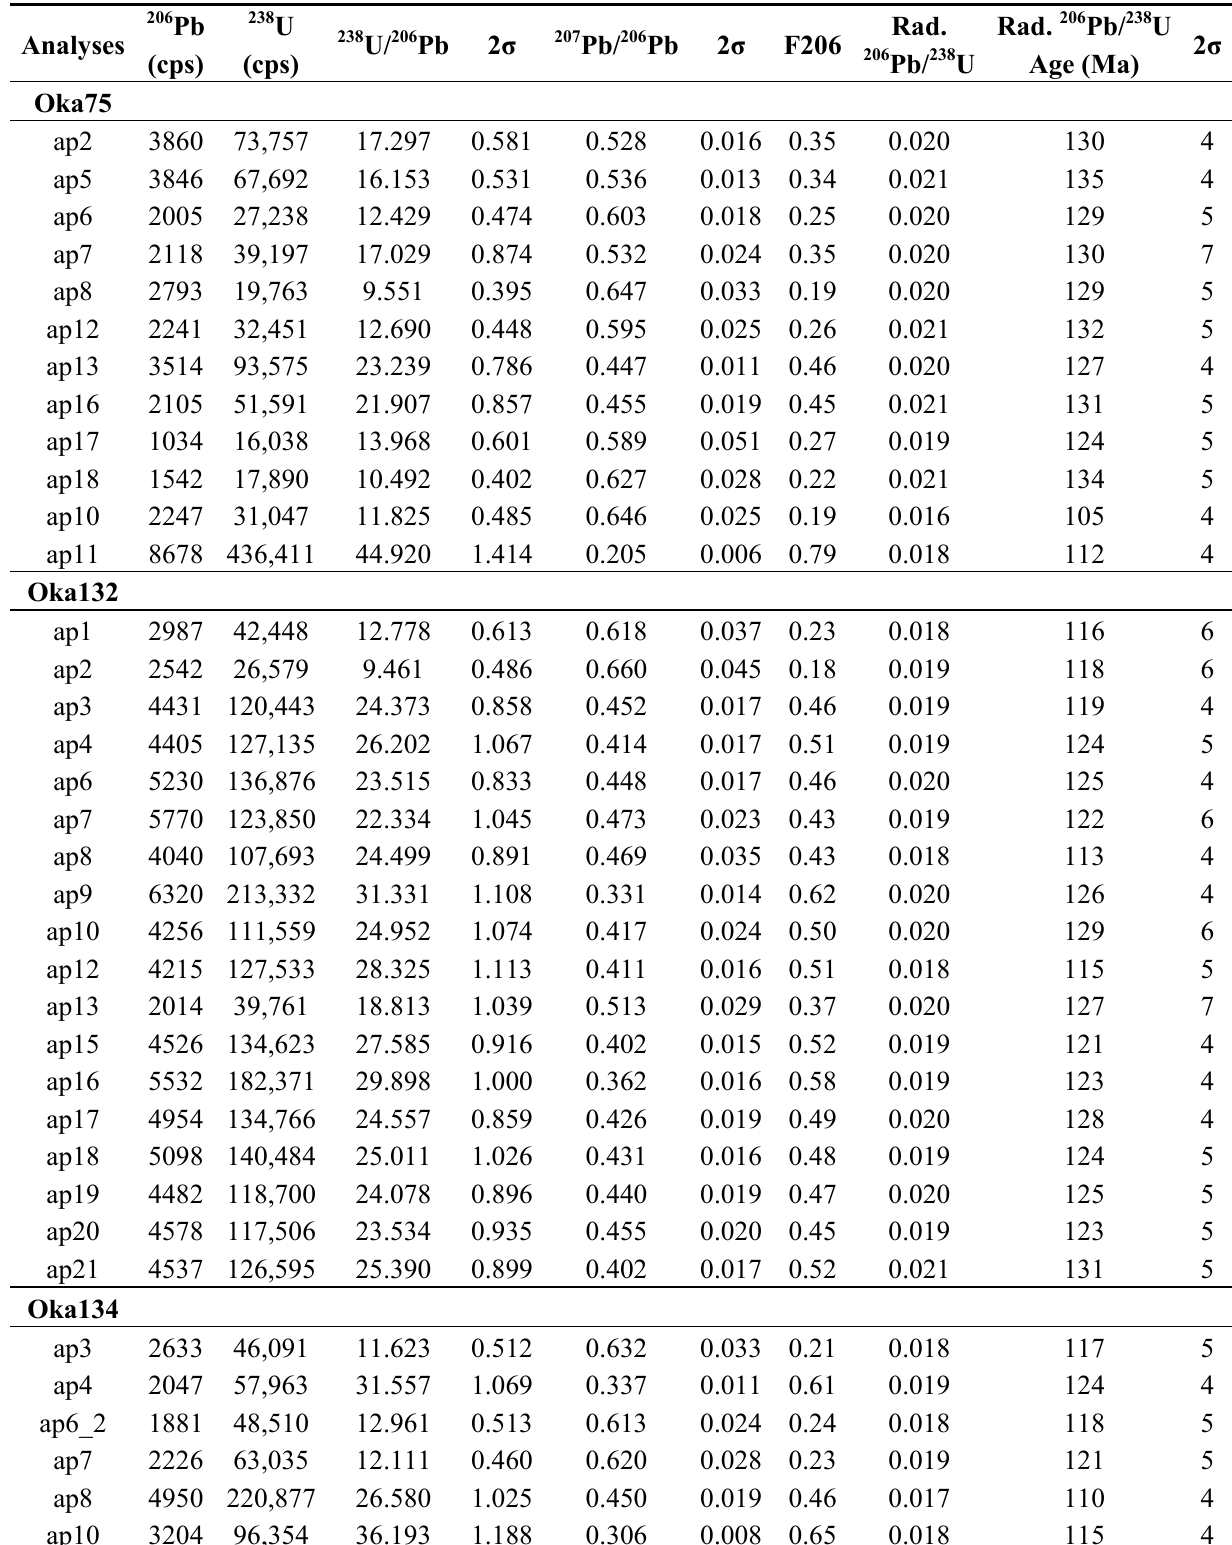
Table 6. In-situ U-Pb geochronological results for apatite by